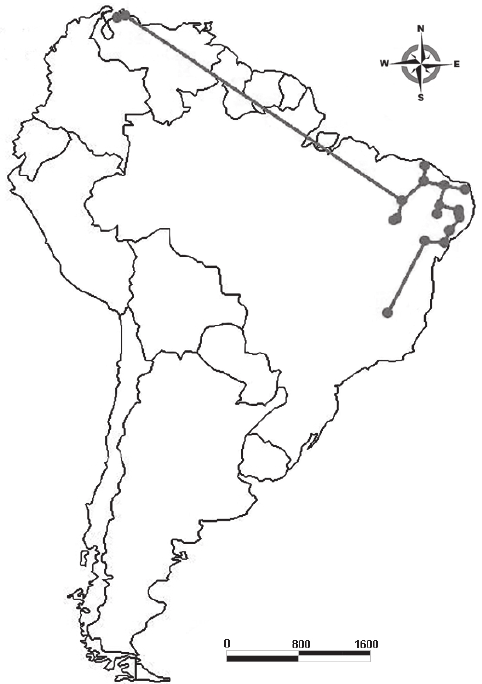
Fig. 4 - Individual track of Glossotherium robustum .